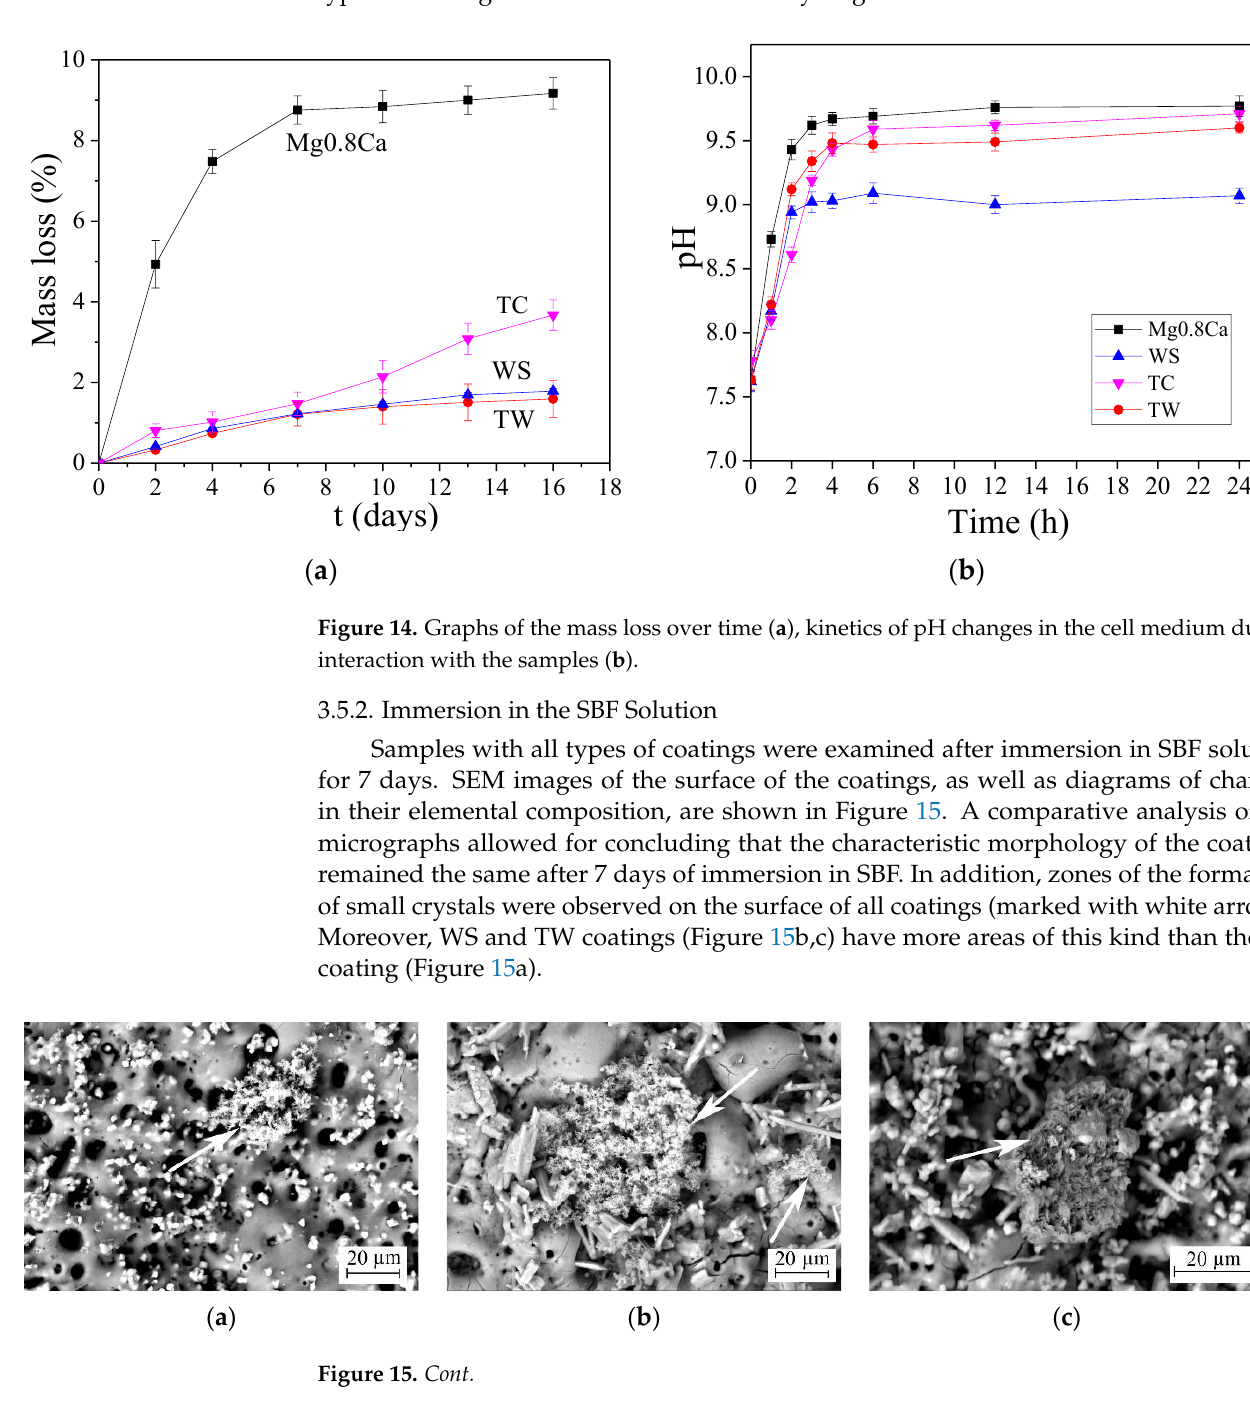
Figure 14. Graphs of the mass loss over time ( a ), kinetics of pH changes in the cell medium during interaction with the samples ( b ).